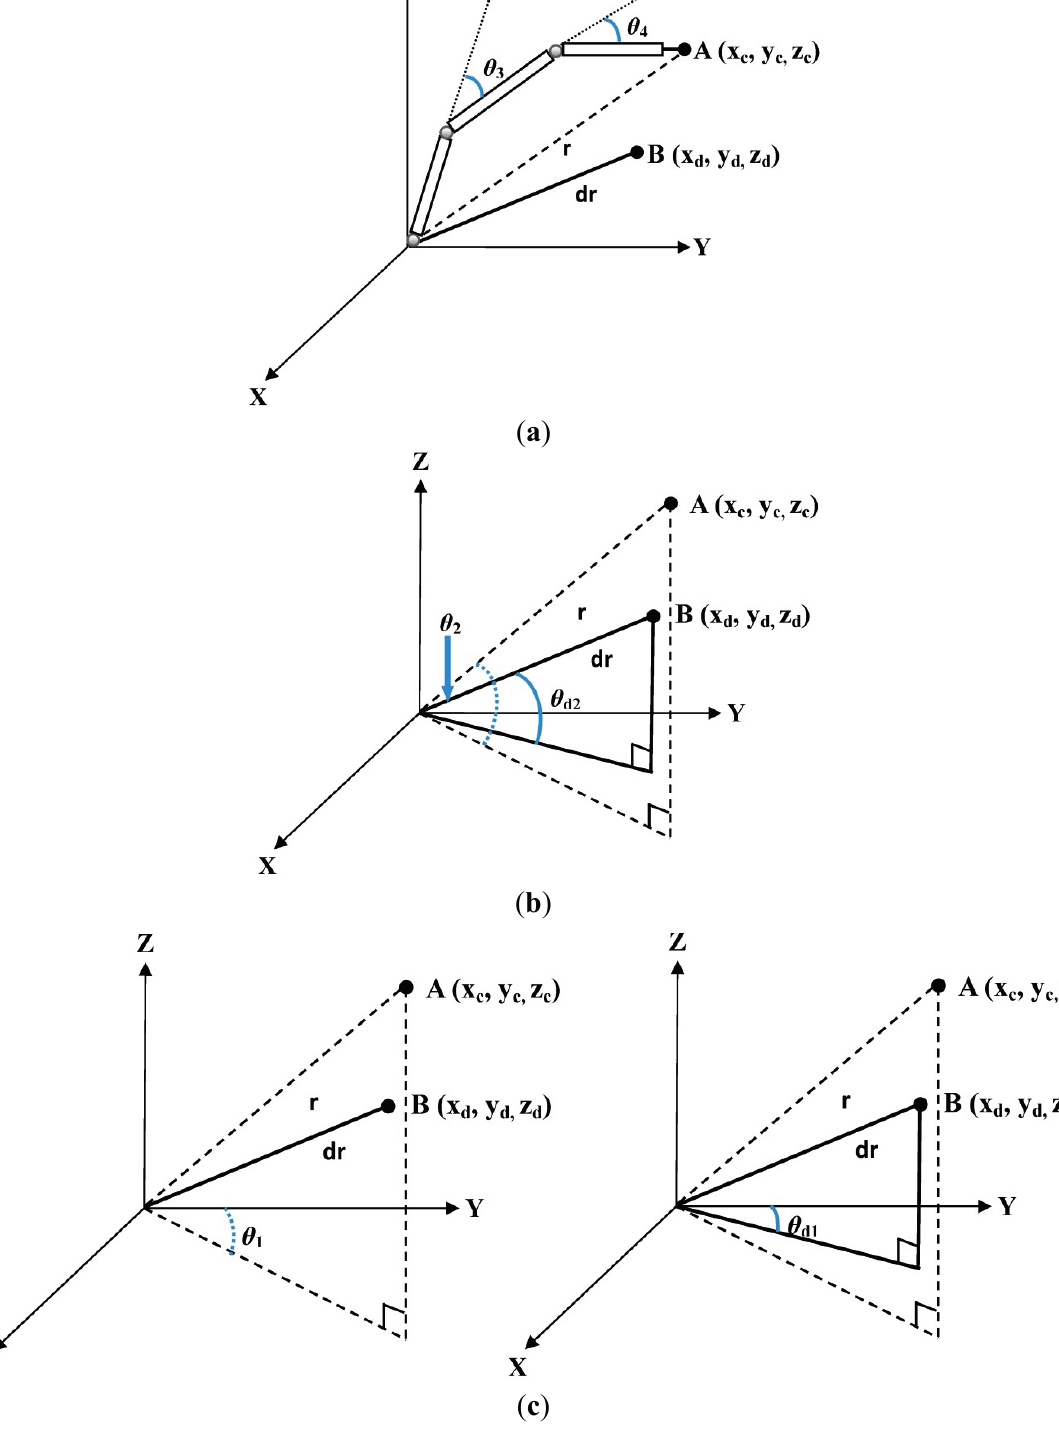
Figure 25. Relationship of the robot arm’s joints. ( a ) Joints 3 and 4; ( b ) Joint 2; ( c ) Joint